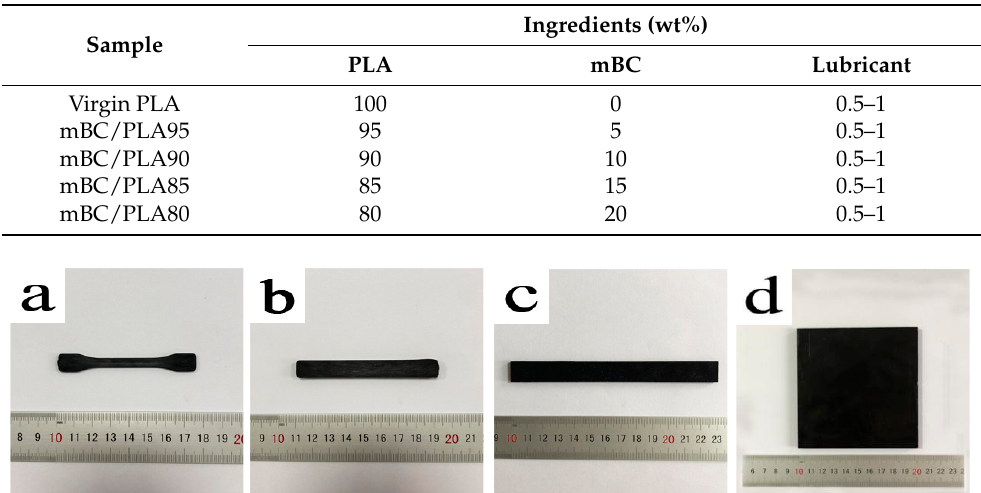
Table 1. Formulations for mBC/PLA composites.